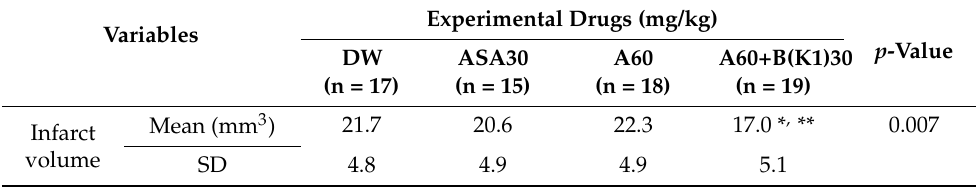
Table 5. Effects of experimental drug A60+B(K1) 30 mg/kg on infarct volume after